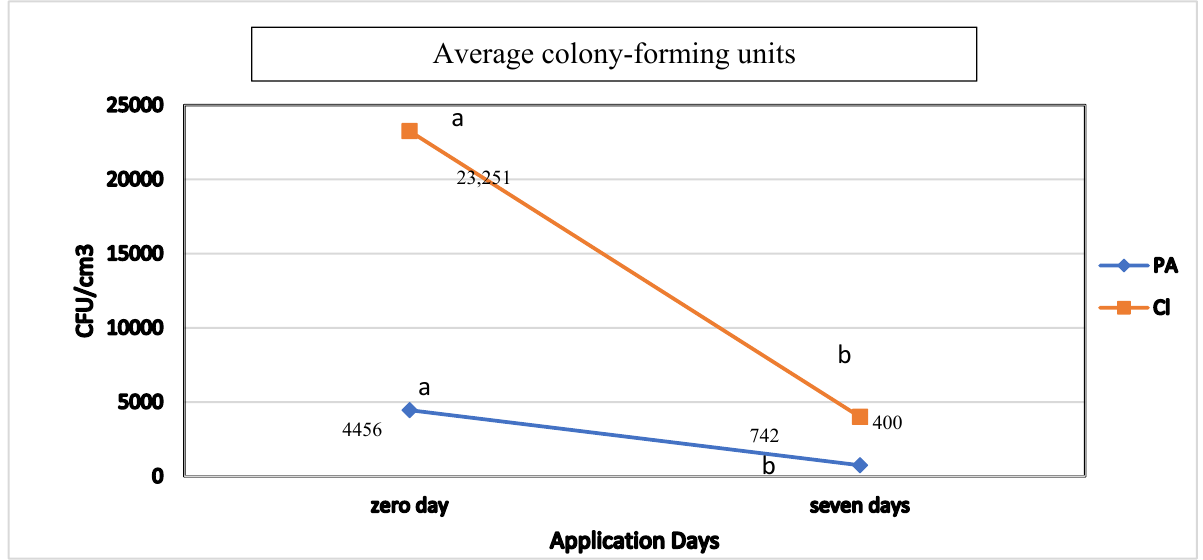
Figure 1. Average colony-forming units during bacterial count at Day 0 and 7 post-surgery when using 20% M. tenuiflora extract and 0.5% chlorhexidine in cats without defined breed subjected to sterilization surgery. CL = positive control (0.5% chlorhexidine-alcohol); PA= 20% Pyroligneous extract of M. tenuiflora . Means followed by different letters (a,b) represent significance ( p < 0.05) in the treatment between days 0 and 7 according to Tukey’s test.